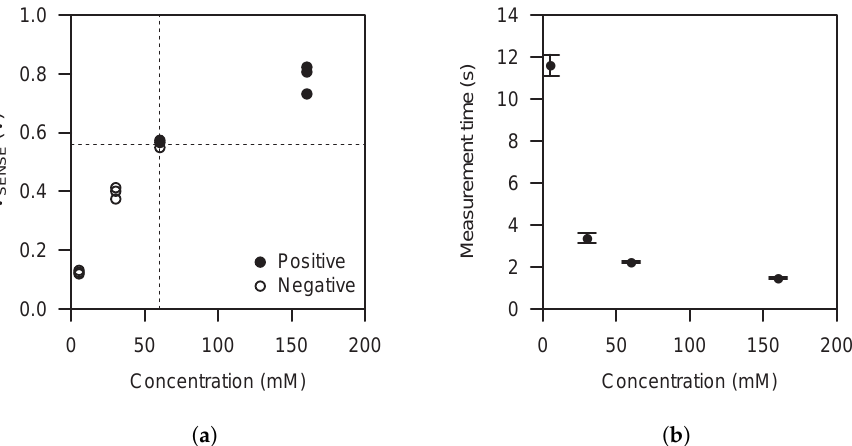
Figure 6. ( a ) Transfer function and comparator output results using the implemented self-powered point-of-care device configured for sample concentration discrimination above and below 60 m M . ( b ) Time needed by the implemented self-powered point-of-care device to perform the measurement for different sample